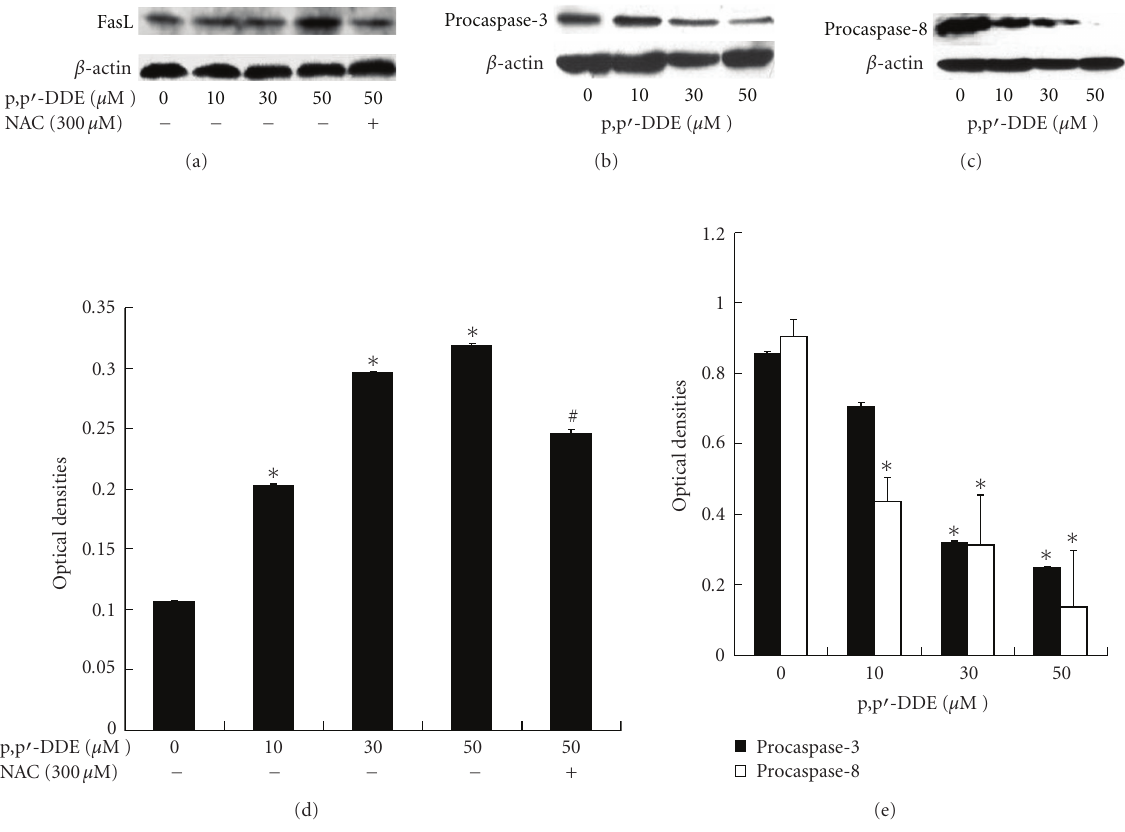
Figure 5: (a) E ff ect of NAC on p,p (cid:2) -DDE-induced FasL protein. Sertoli cells were treated with p,p (cid:2) -DDE pretreated with or without NAC. Protein from whole cell lysates was used in Western blotting for FasL detection. (b)–(c) Procaspase-3 and -8 in Sertoli cells exposed to p,p (cid:2) -DDE for 24 hours. Protein from whole cell lysates was used in Western blotting for procaspase-3 and -8 detection. (d)–(e) Quantitative analysis of the immunoreactive FasL and procaspase-3 and -8. Data are indicated as mean ± SD. Significant di ff erence is ( ∗ ) P < . 05, compared with the control group is ( # ) P < . 05, compared with 50 μ M p,p (cid:2) -DDE group.